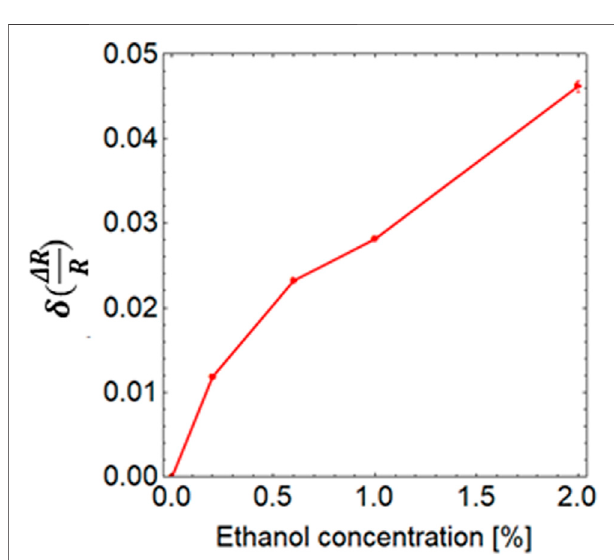
FIGURE 10 | δ ( Δ R / R ) as a function of the ethanol gas concentration.